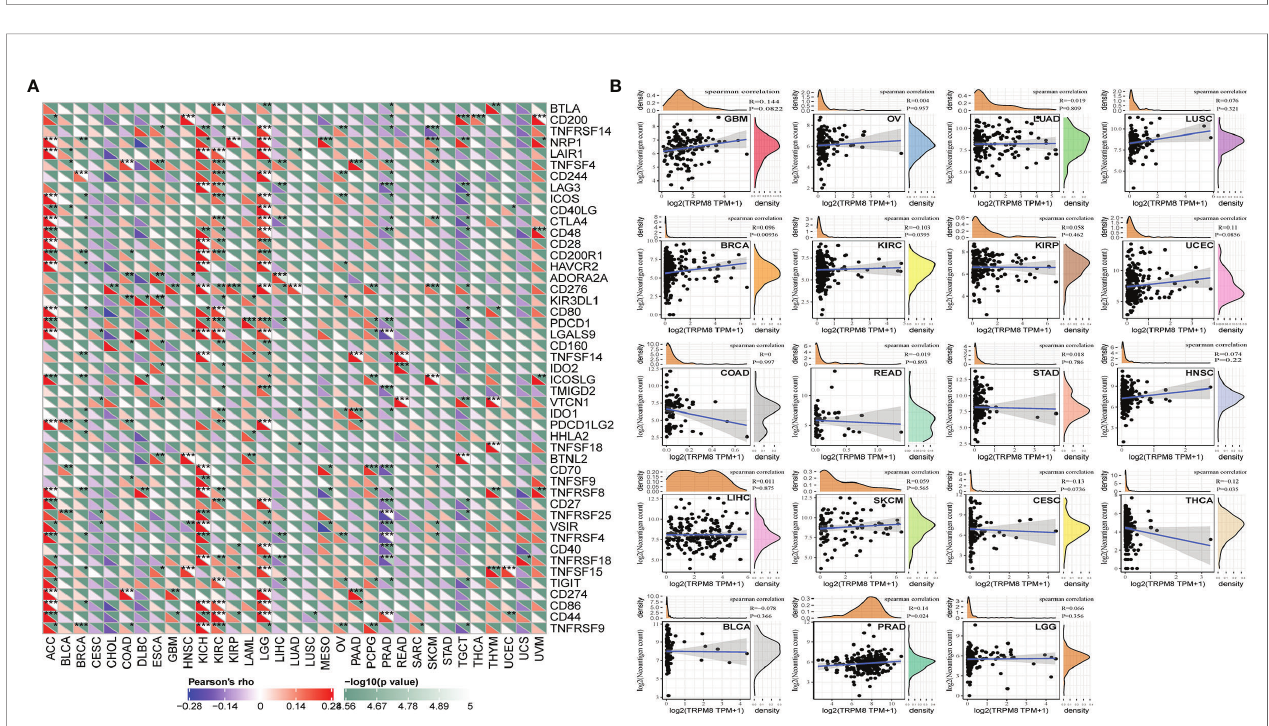
FIGURE 8 | Relationships between TRMP8 and immune neoantigens and checkpoint genes. (A) Relationship between TRPM8 and checkpoint gene levels. *P < 0.05, **P < 0.01, and ***P < 0.001. (B) Relationship between TRPM8 and neoantigen numbers in 19 tumor types.